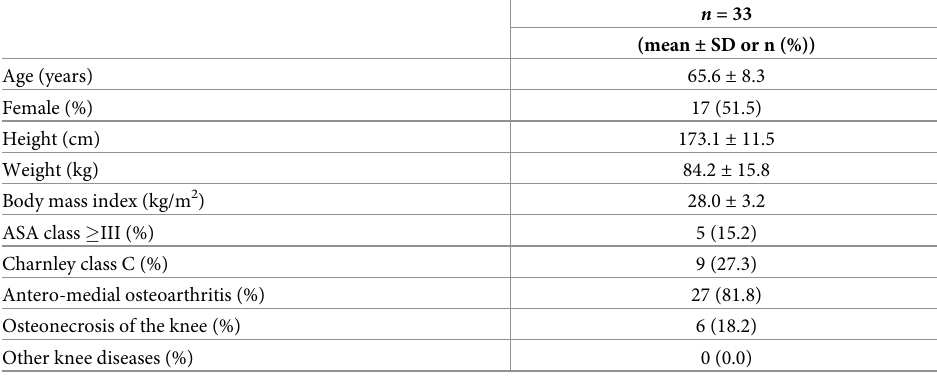
Table 1. Patient characteristics and type of degenerative knee disease a